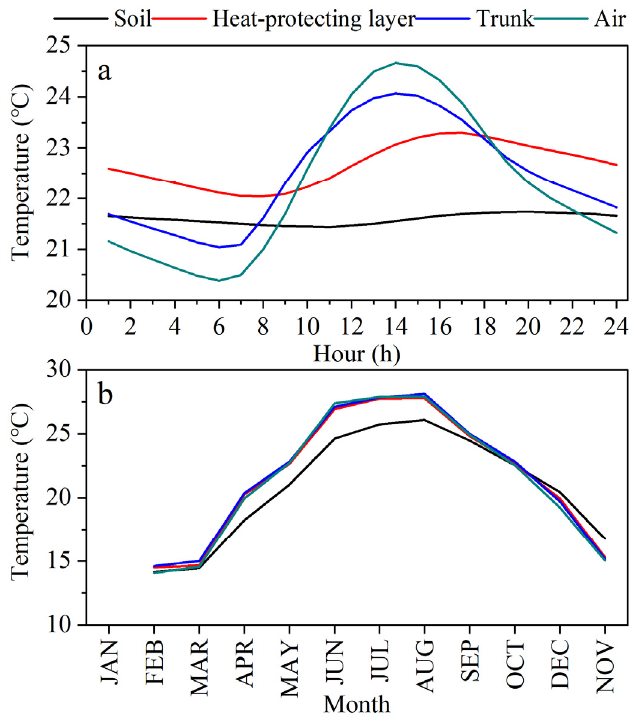
Figure 3. ( a ) Mean hourly and ( b ) monthly temperatures for the soil, heat-protecting layer, trunk and air from 13 February to 16 December in the year 2015.